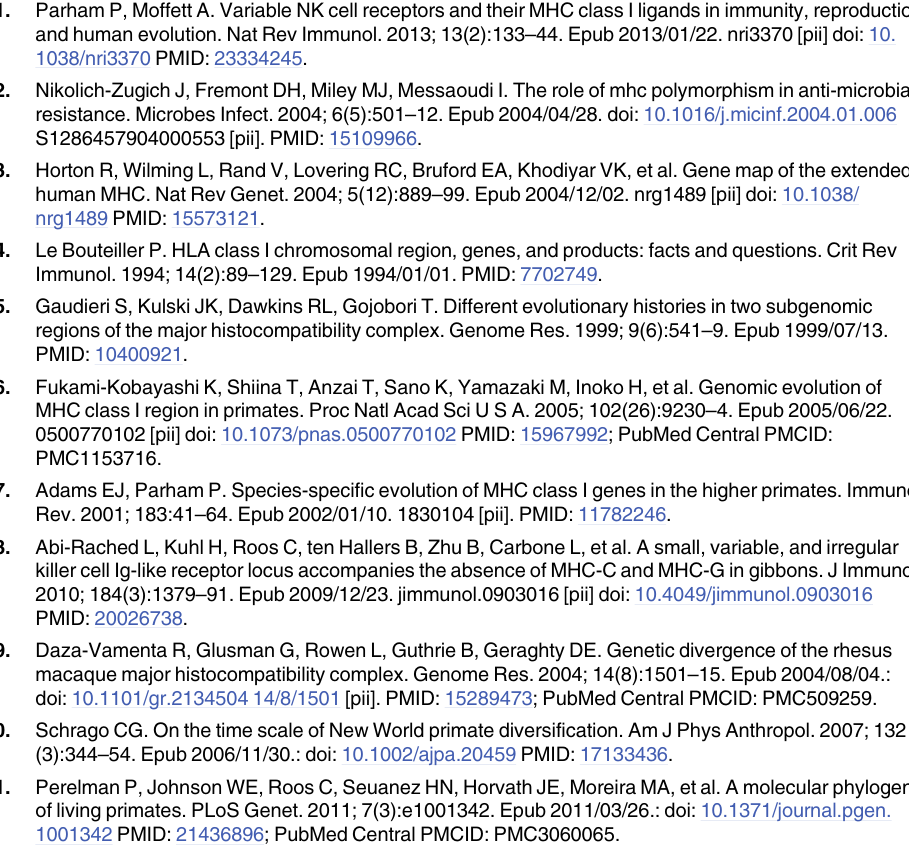
S2 Table. Variability of MHC-G-like and — B positions predicted to interact with KIR domains D1 and D2 in C . albifrons . S3 Table. Additional Platyrrhini MHC class I sequences used for phylogenetics